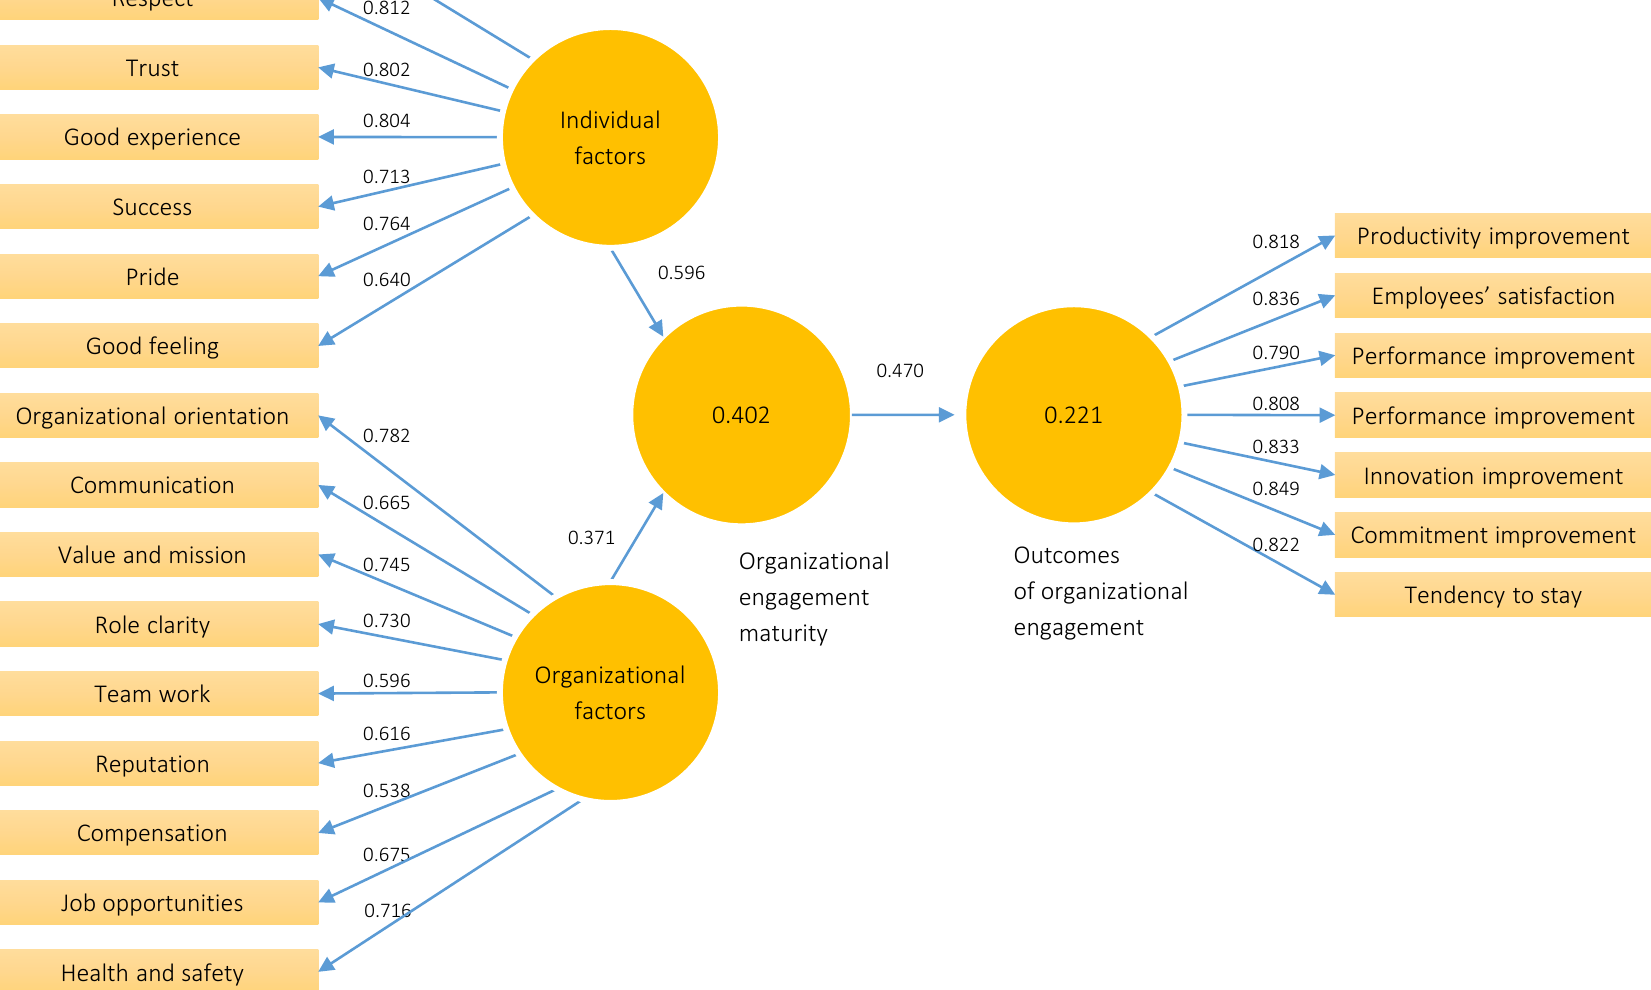
Figure 3. The effective factors of employees’